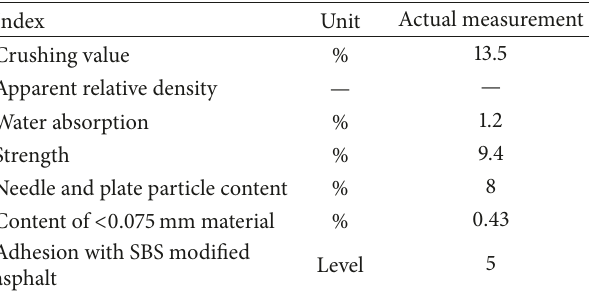
Table 2: Technical indexes of coarse